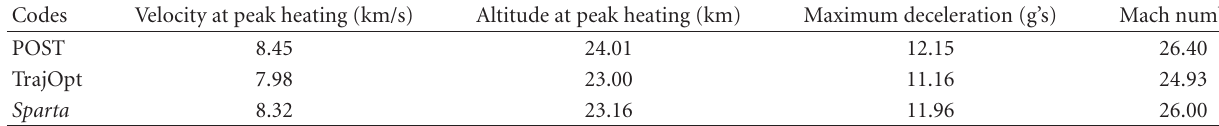
Table 5: Benchmarking analysis for Apollo 6 at an entry angle of − 5 . 9 ◦ .